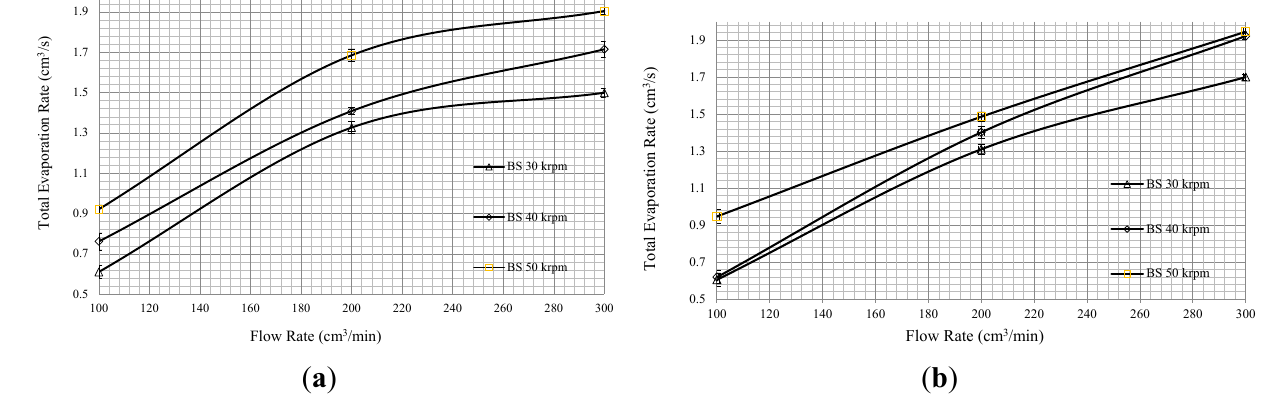
Figure 3. Total evaporation rate (cm 3 /s) for different bell speeds and flow rates at ( a ) 300 L/min shaping air, ( b ) 200 L/min shaping